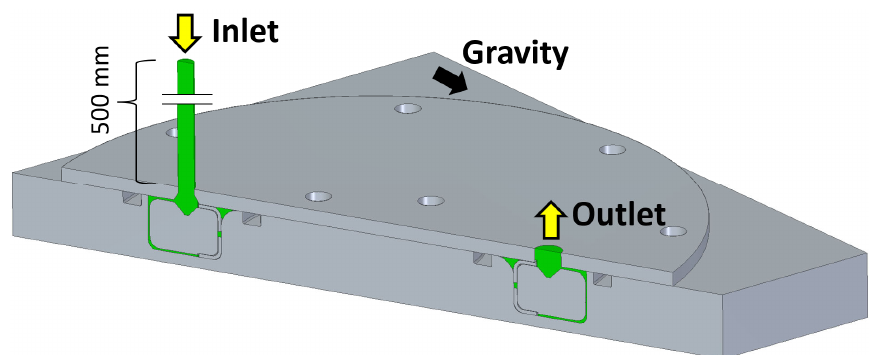
Figure 9. Generating the fl ow fi eld from the test damper ’s CAD model in section view.